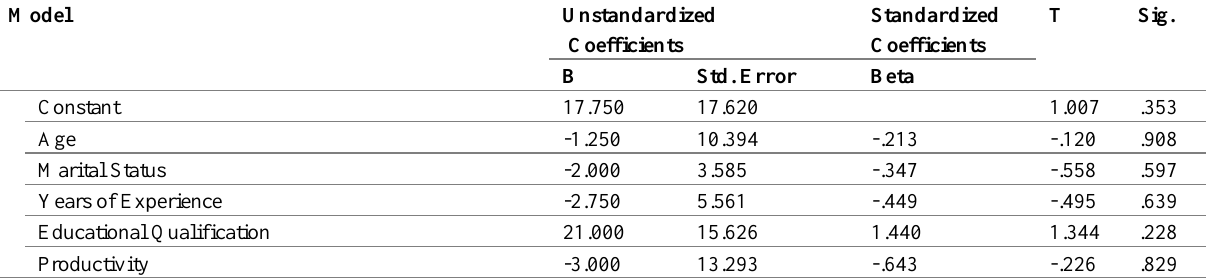
Table 8: Regression Analysis Showing the Relationship Between Demographic Variables and Productivity Model